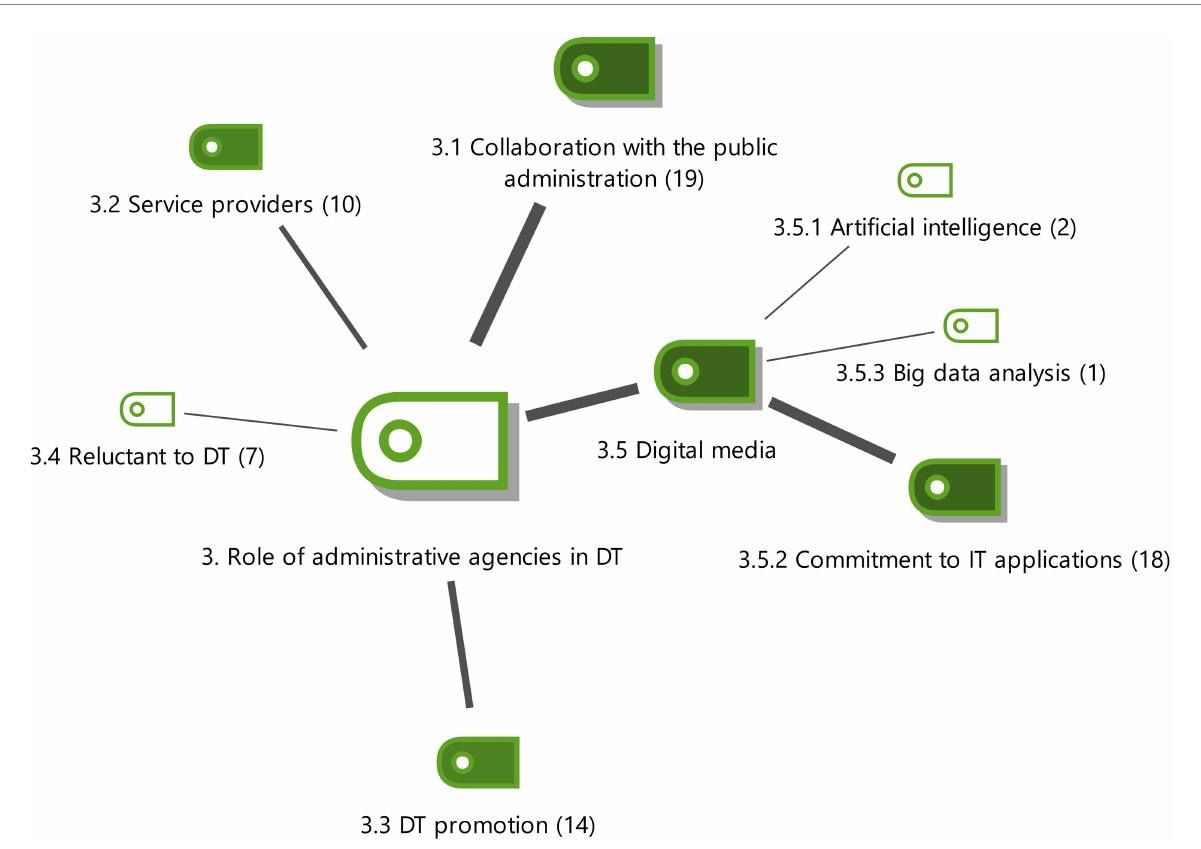
FIGURE 3 Role of the Administrative Agencies in DT with the weightings of the properties. Source: authors own.